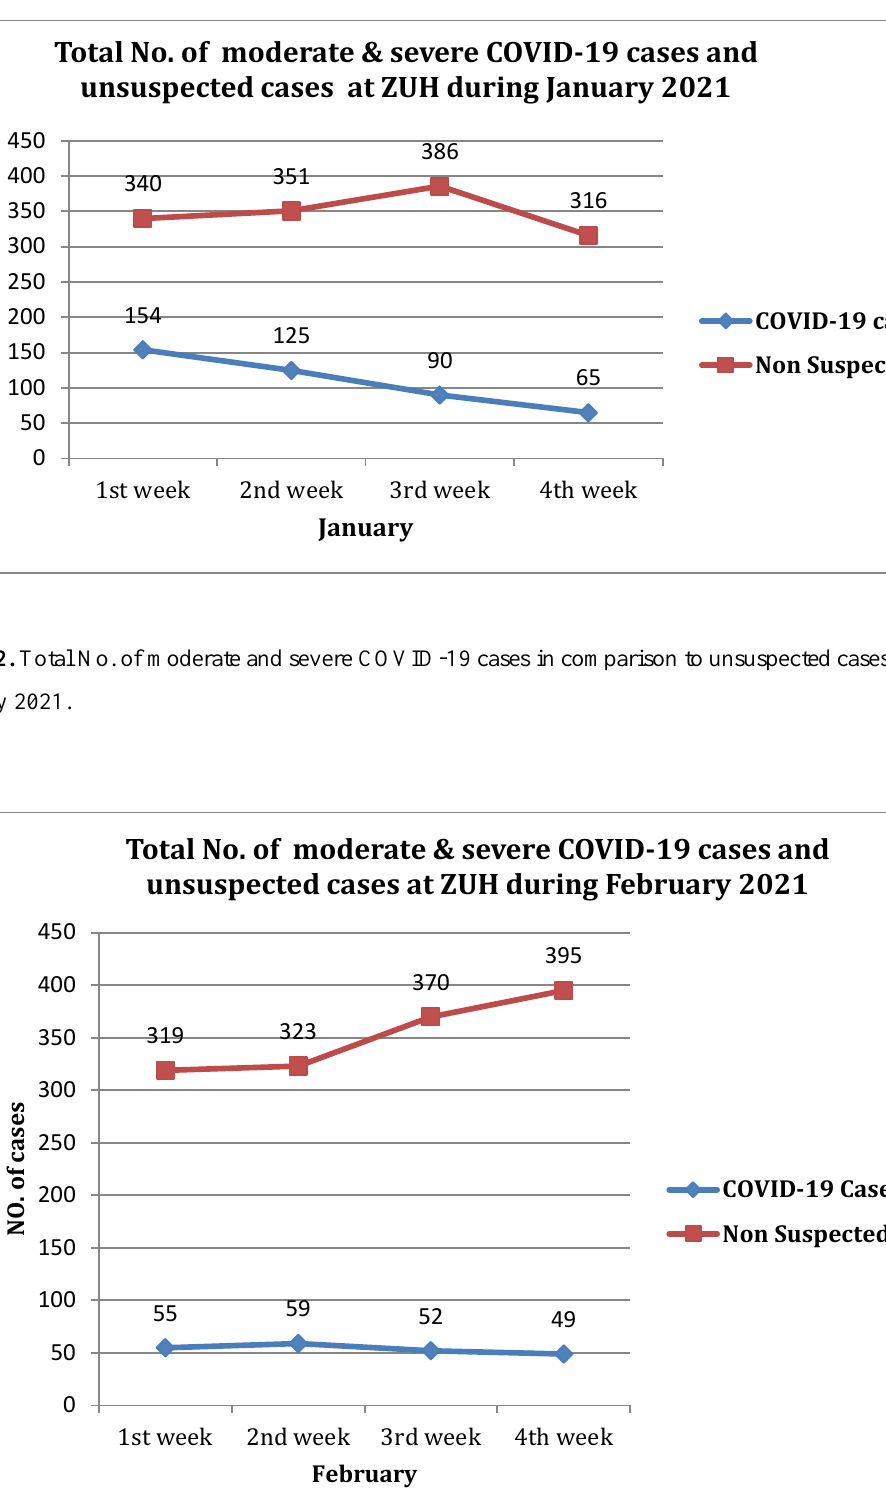
Figure 1. Total No. of moderate and severe COVID-19 cases in comparison to unsuspected cases at ZUH during January 2021.